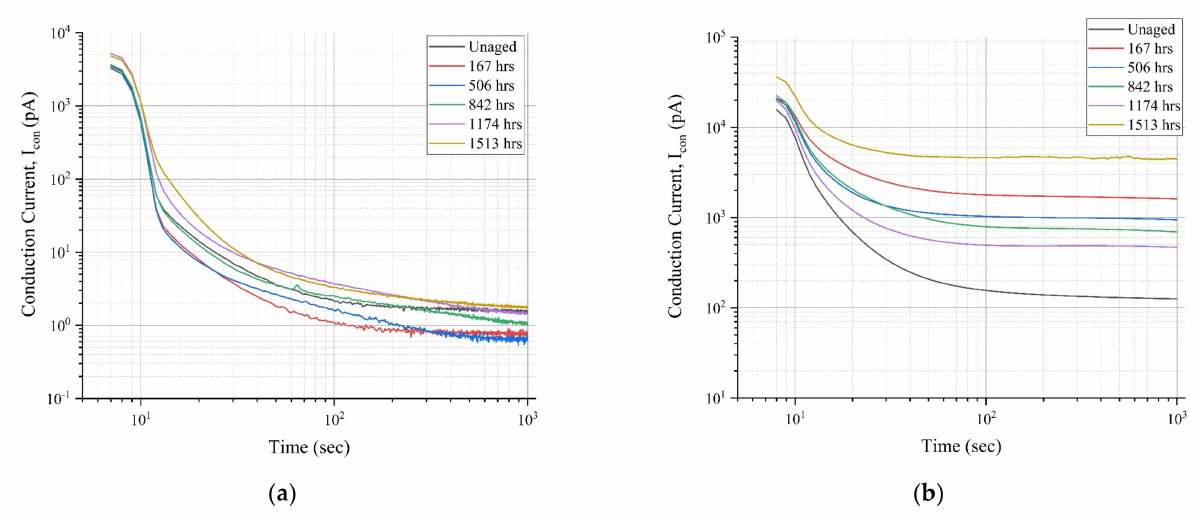
significant increases in the overall S d , relative conductivity, values, and conduction current, Figure 11a, also support the phenomenon.